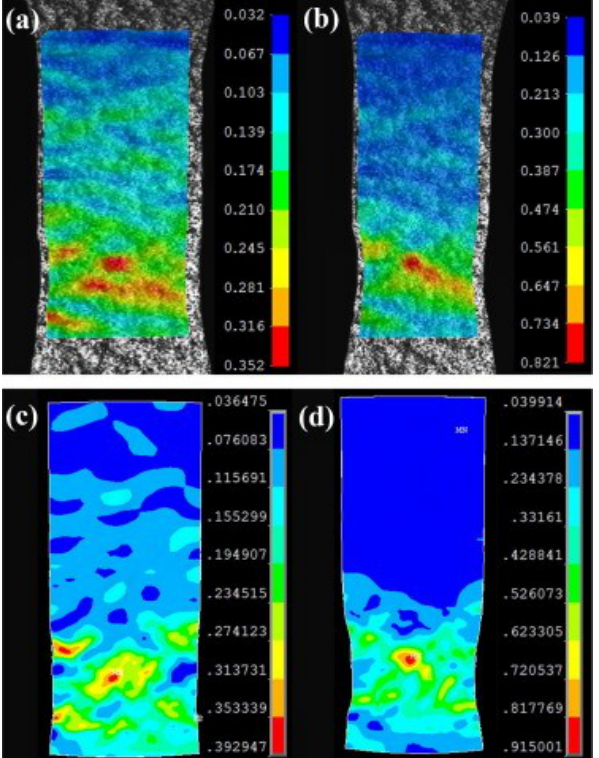
Figure 7. Strain distribution in a specimen subjected to tensile loading obtained experimentally ( a,b ) and numerically ( c,d )